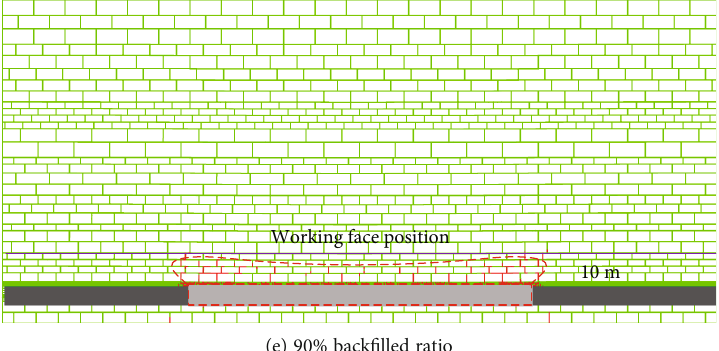
Figure 7: Evolution characteristics of water-conducting fractures in the overburden under di ff erent mining conditions.